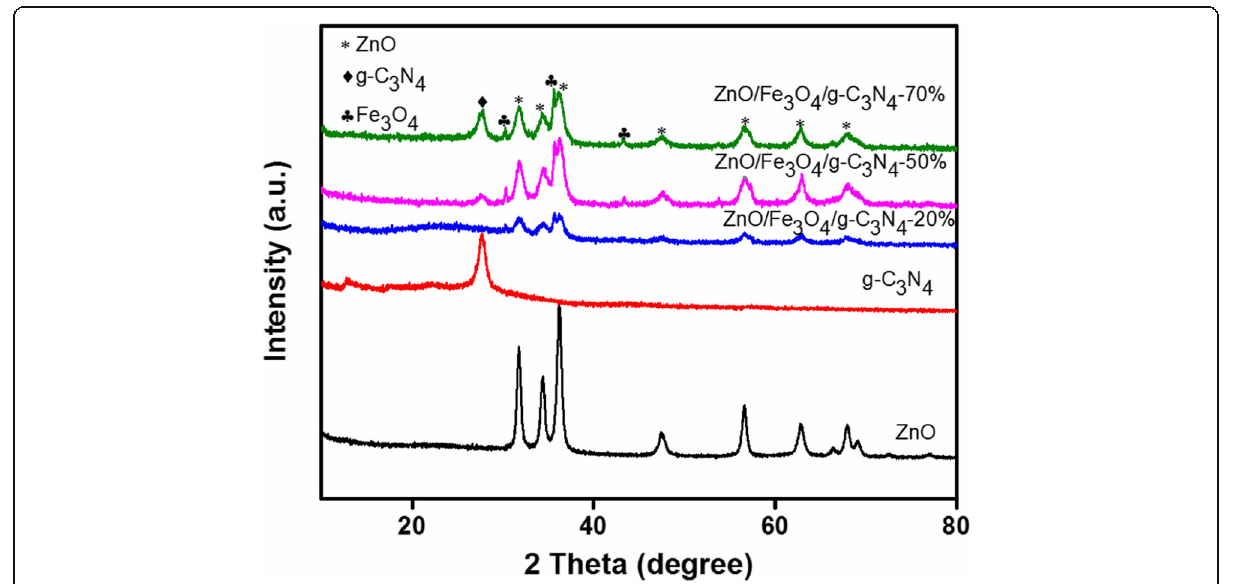
Fig. 1 XRD patterns of ZnO, g-C 3 N 4 , ZnO/Fe 3 O 4 /g-C 3 N 4 -20%, ZnO/Fe 3 O 4 /g-C 3 N 4 -50%, and ZnO/Fe 3 O 4 /g-C 3 N 4 -70%